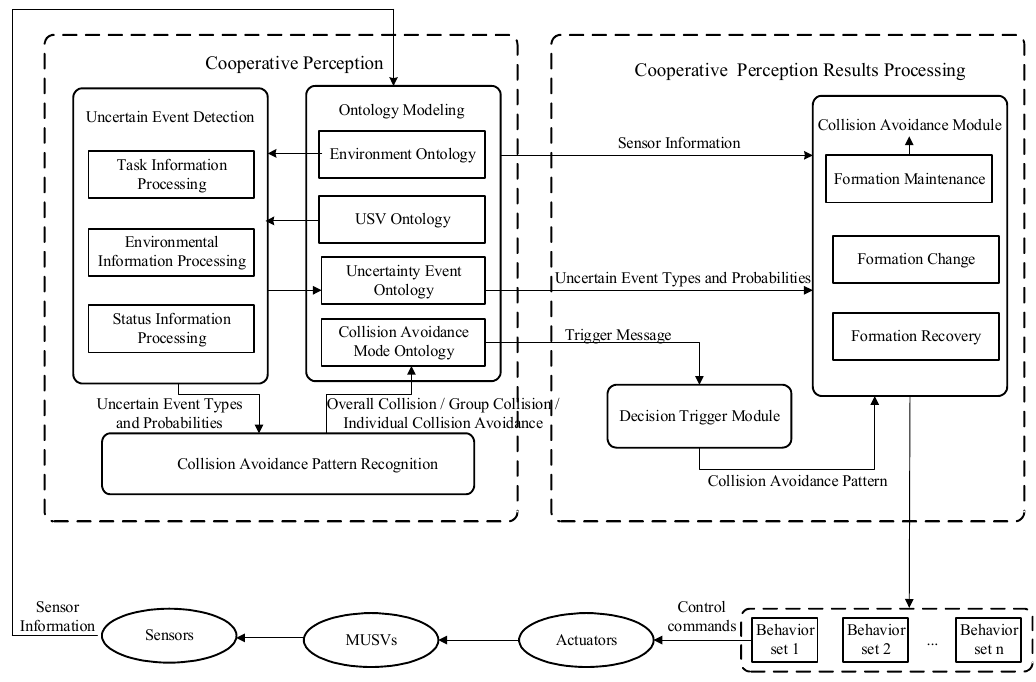
Figure 1. Cooperative perception process diagram.